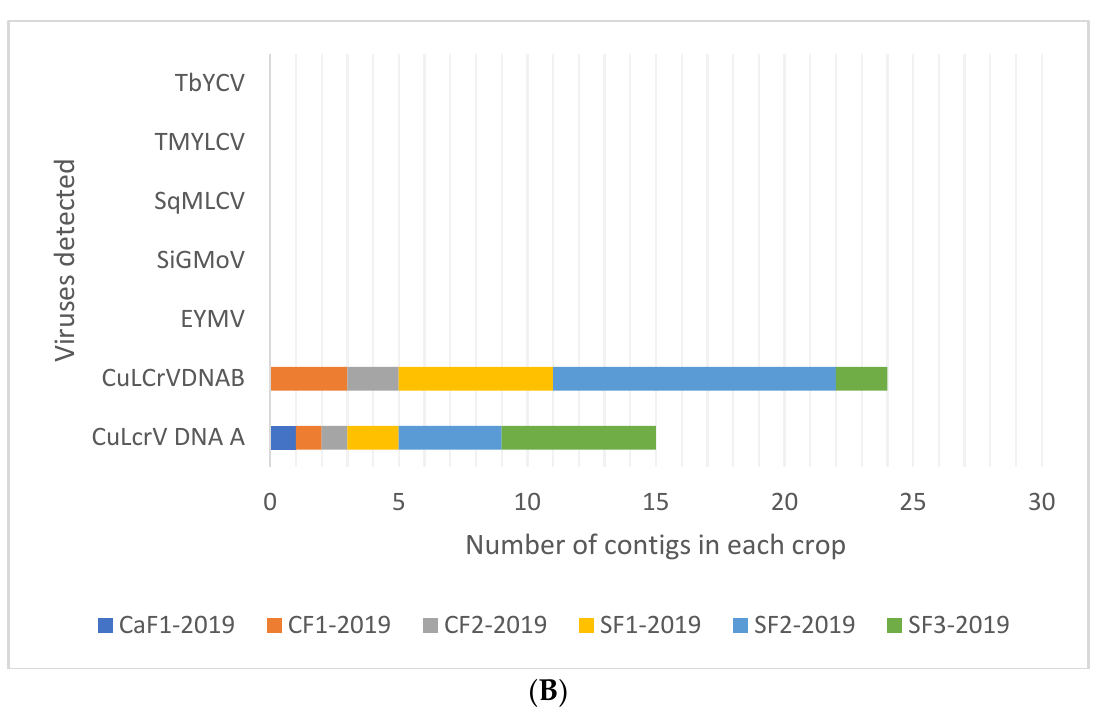
Figure 2. ( A ) Viruses detected on cantaloupe (CaF1-2019, CaF1-2020, CaF2-2019), cucumber (CF1-2019, CF2-2019, CF1-2020), and squash (SF1-2019, SF1-2020, SF2-2020) in Georgia by high throughput sequencing (HTS) of small RNAs ( A ) and RCA-HTS ( B ). Viruses detected and their genomic components are presented along the Y-axis. The number of contigs of each genome detected are presented along the X-axis. Each grid in the graph represents one contig and each color represents a different sample. Abbreviations used for viruses: Cucurbit chlorotic yellows virus (CCYV), cucurbit yellow stunting virus (CYSDV), cucurbit leaf crumple virus (CuLCrV), euphorbia yellow mosaic virus (EYMV), squash mild leaf curl virus (SqMLCV), sida golden mottle virus (SiGMoV), tomato mild yellow leaf curl virus (TmYLCV), and tobacco yellow crinkle virus (TbYCV).